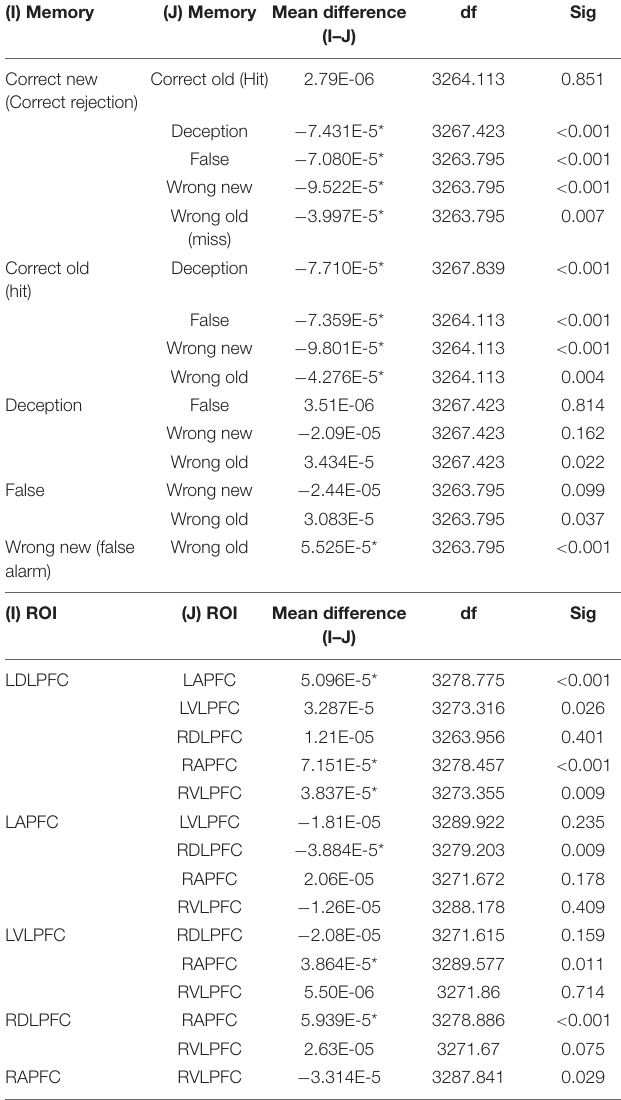
TABLE 2 | Pairwise comparisons for memory conditions and brain regions of